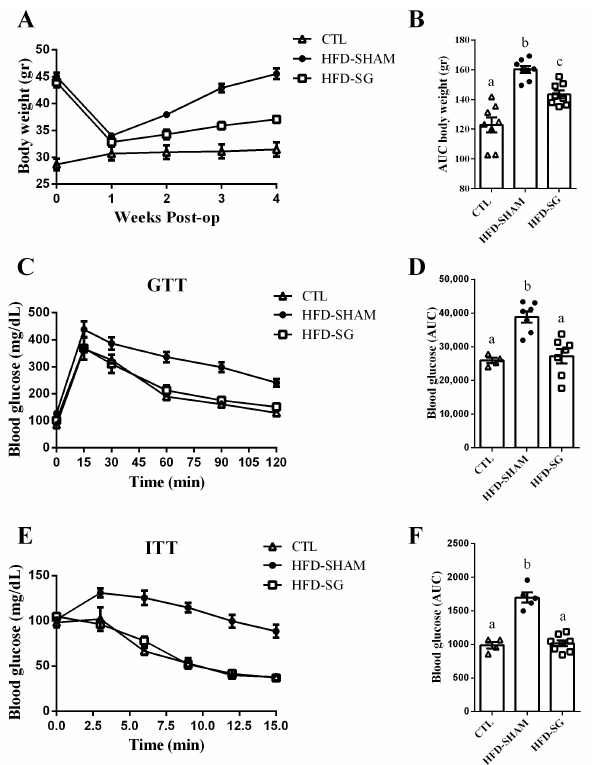
Figure 2. SG reduces body weight gain and improves glucose tolerance and insulin sensitivity in HFD-SG mice. Postoperative body weight ( A ) and its respective area under the curve (AUC) ( B ) of CTL, HFD-SHAM, and HFD-SG mice (n = 8). Blood glucose of CTL, HFD-SHAM, and HFD-SG mice during the intraperitoneal glucose tolerance test (ipGTT) ( C ) (n = 4–7). The area under the curve (AUC) of total blood glucose concentration of CTL, HFD-SHAM, and HFD-SG mice during ipGTT ( D ) (n = 4–7). Blood glucose of CTL, HFD-SHAM, and HFD-SG mice during the intraperitoneal insulin tolerance test (ipITT) ( E ) (n = 4–8). The area under the curve (AUC) of total blood glucose concentration of CTL, HFD-SHAM, and HFD-SG mice during ipITT ( F ) (n = 4–8). Data are the mean ± SEM. Different letters indicate statistical differences between groups, p ≤ 0.05 (one-way ANOVA or Kruskal–Wallis test).